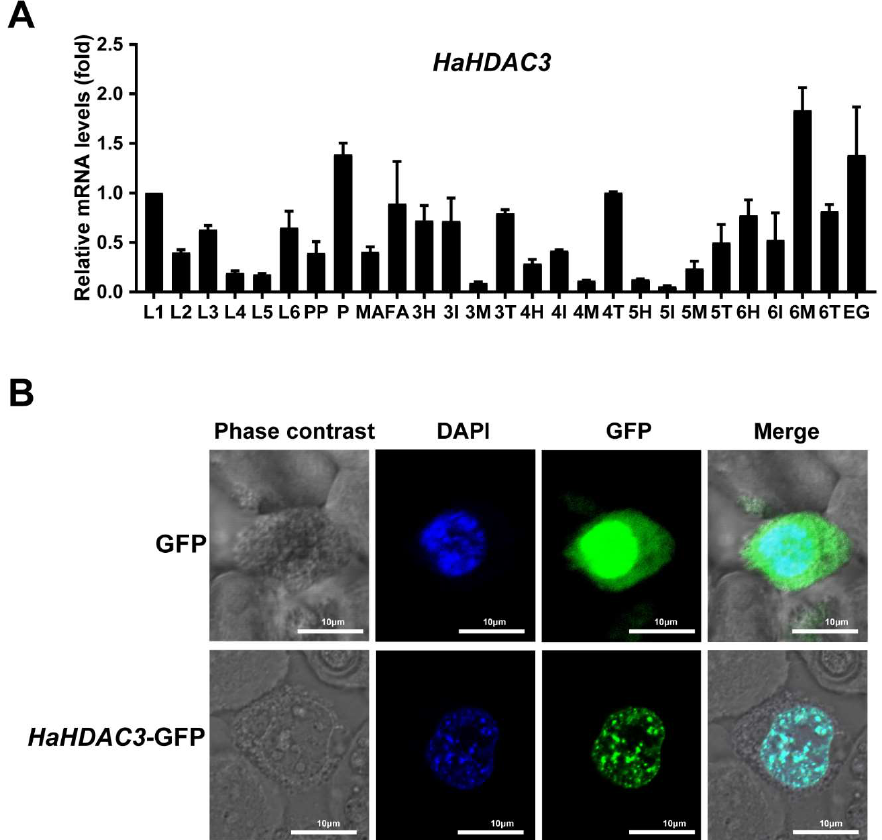
Figure 2. Spatial and temporal expression level and subcellular localization of HDAC3 in H. armigera . ( A ) Larval stage (L1–L6), eggs (EG), prepupae (PP), pupae (P), female adults (FA), male adults (MA), head (H), integument (I), midgut (M), and malpighian tubules (T) (the numbers indicate the instar stages that used for sampling). Total RNA isolated from a pool of two larvae for each replication was converted to cDNA, and RT-qPCR was used to determine HDAC3 mRNA relative expression. The mean ± SE (n = 4) is shown. ( B ) HaHDAC3 was transiently expressed in Sf9 cells to determine its subcellular localization. The green color shows the fluorescent signal of GFP expression. After staining with 4,6-diamidino-2-phenylindole (DAPI), the chromosome fluoresced blue, revealing the nuclear localization of HaHDAC3.